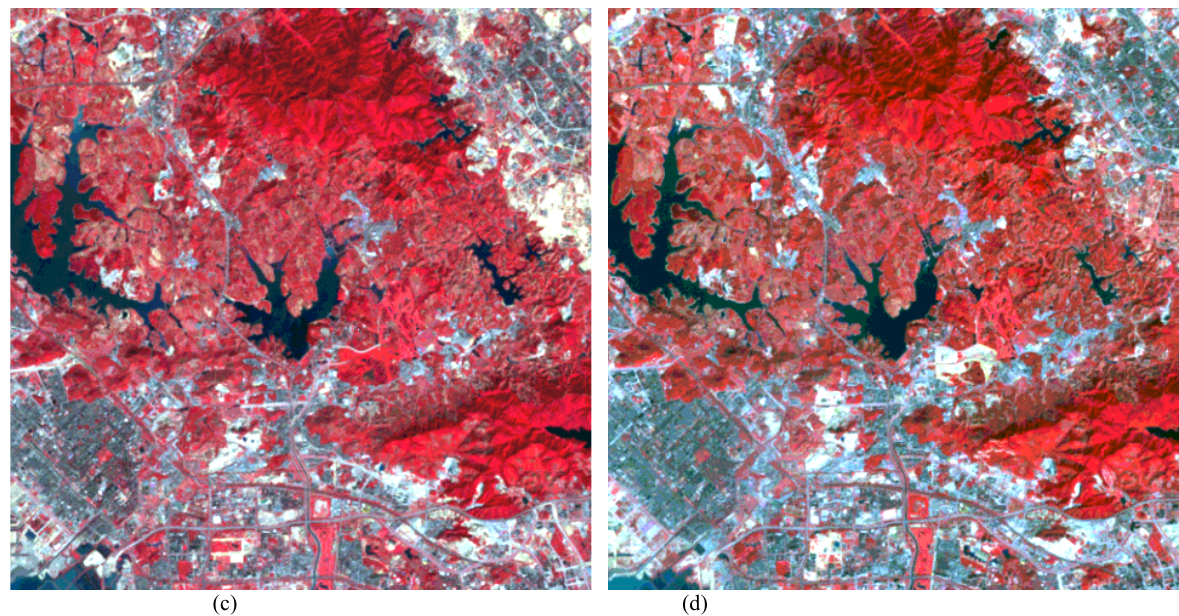
Figure 1. Shenzhen, China Data Set. The upper two are NIR-red-green composites of MODIS surface reflectance at 250 m spatial resolution (red band has 500m spatial resolution which has been interpolated to 250m), the lower two show corresponding Landsat